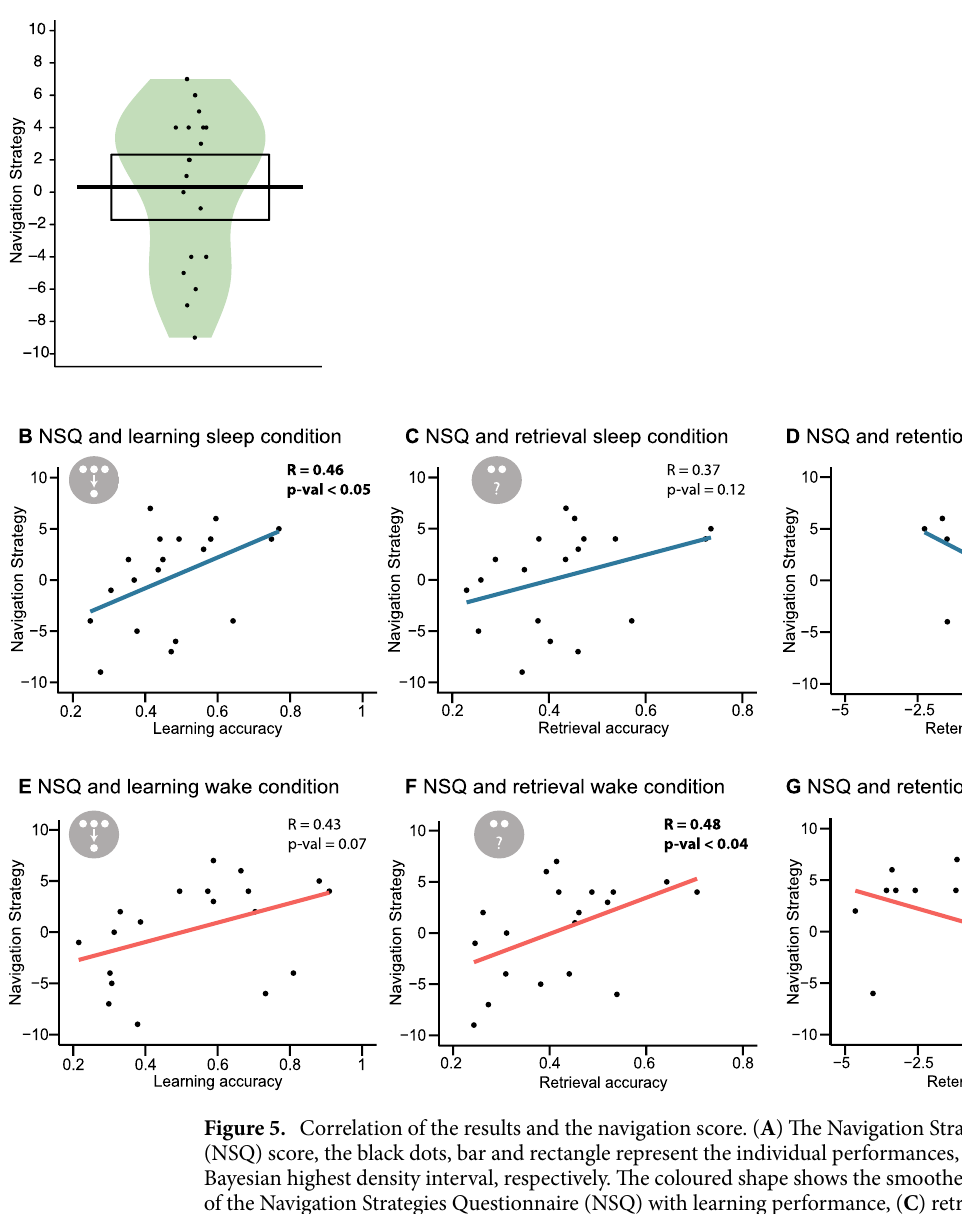
Bayesian highest density interval, respectively. The coloured shape shows the smoothed density. ( B ) Relationship of the Navigation Strategies Questionnaire (NSQ) with learning performance, ( C ) retrieval performance and ( D ) retention performance for the sleep condition and with ( E ) learning performance, ( F ) retrieval performance and ( G ) retention performance for the wake condition. Regression lines (blue—sleep, red—wake) and black dots for the individual data points are